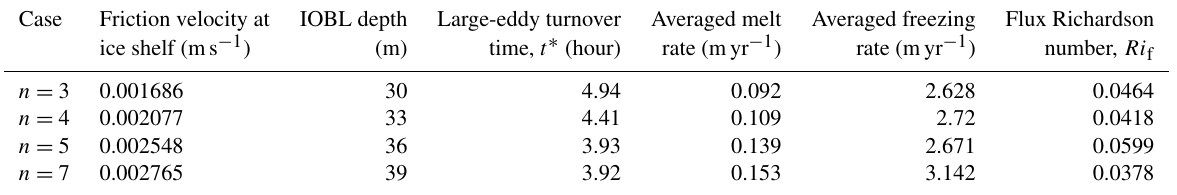
Table 2. Main values of four different cases ( Ri f